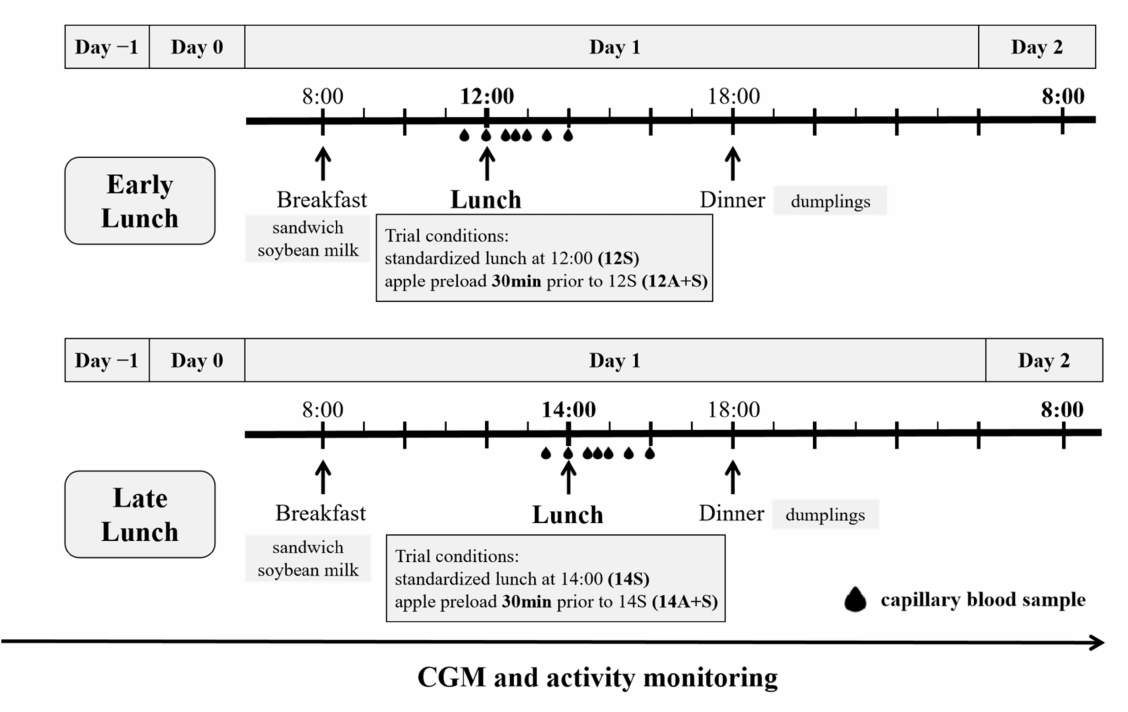
Figure 1. Summary of the study experimental design. CGM, continuous glucose monitor. All participants underwent four lunch trial conditions in a randomized order, including standardized lunch at 12:00 (12S); apple preload 30 min prior to 12S (12A+S); standardized lunch at 14:00 (14S); apple preload 30 min prior to 14S